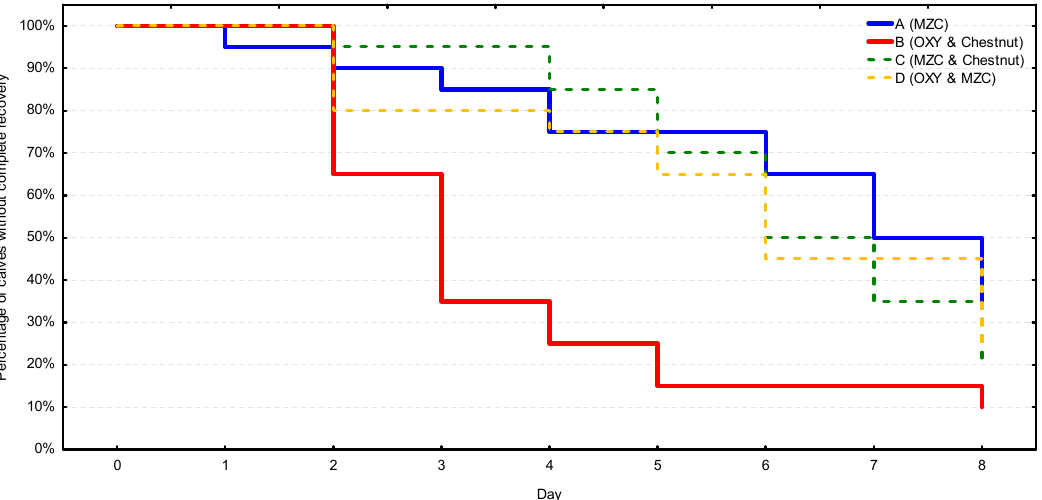
Figure 4. Thecompleterecoveryratefromdiarrhea (i.e., completeandsustaineddisappearanceofdiarrhea) Figure 4. The complete recovery rate from diarrhea (i.e., complete and sustained disappearance of in four groups ( n = 20 calves / group). MZC—micronized zeolite clinoptilolite, diarrhea) in four groups ( n = 20 calves/group). MZC—micronized zeolite clinoptilolite, OXY— oxytetracycline.